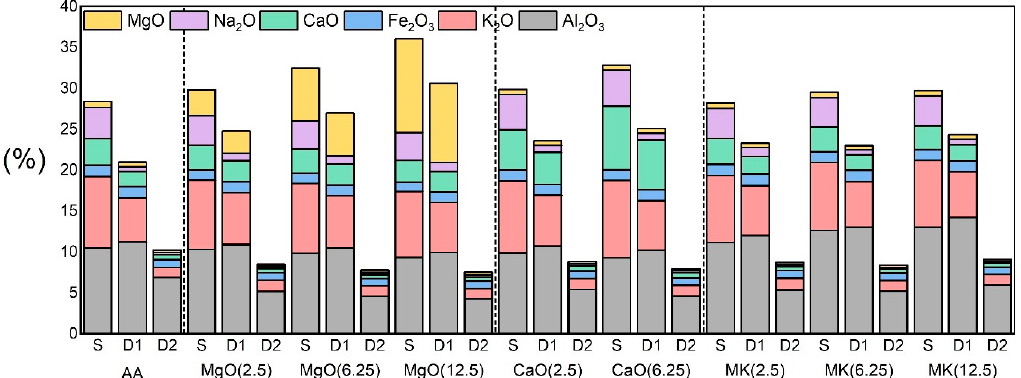
Figure 1. Chemical composition of samples (silicon is up to 100%).